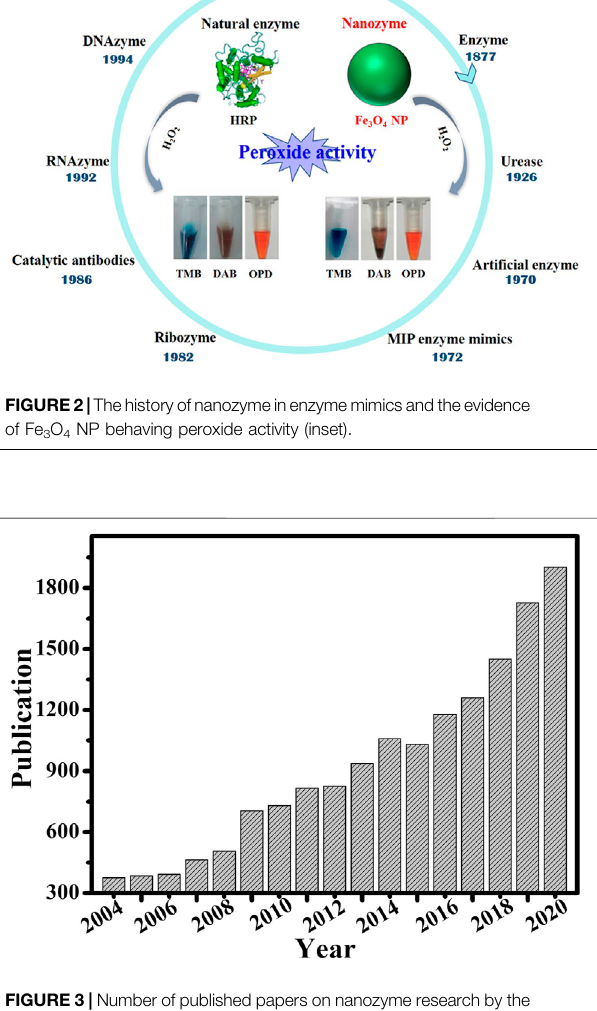
FIGURE 3 | Number of published papers on nanozyme research by the end of 2020. The data is based on the Web of